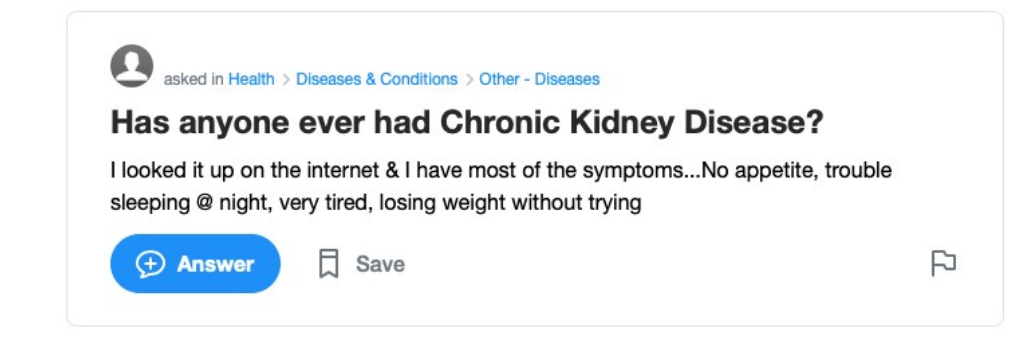
Figure 2. Illustrations of information seeking and sharing behavior in multi-disease health